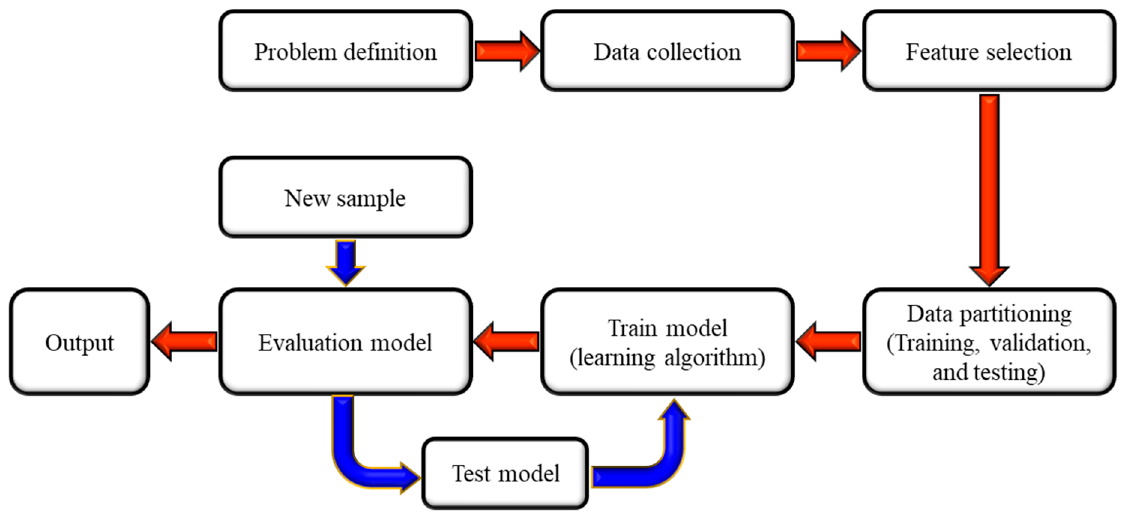
Figure 7. Machine learning implementation stages.